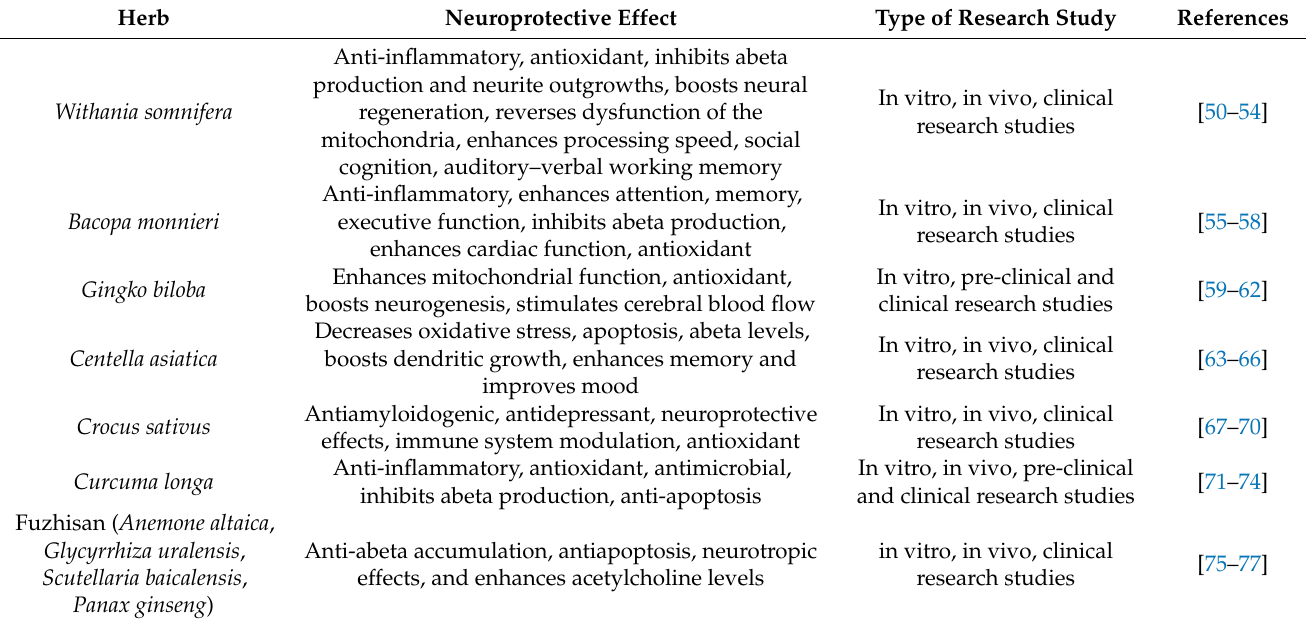
Table 1. The neuroprotective effects of herbs administrated for AD treatment. Neuroprotective herbs act via various mechanisms to elicit their ameliorative effects on AD patients. The neurotherapeutic effects of the herbs aid in the restoration and enhancement of memory and cognitive